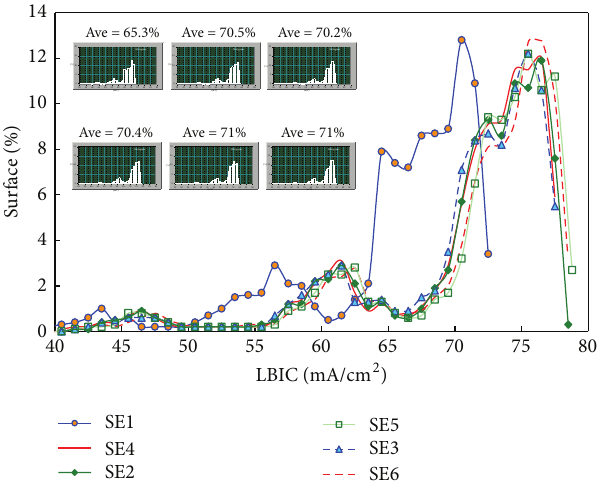
Figure 7: Comparison with LBIC (mA/cm 2 ) of the occupied minority carriers (%) and average values (%) on surface of six SE samples. The inset histograms are real-distribution profiles of corresponding LBIC